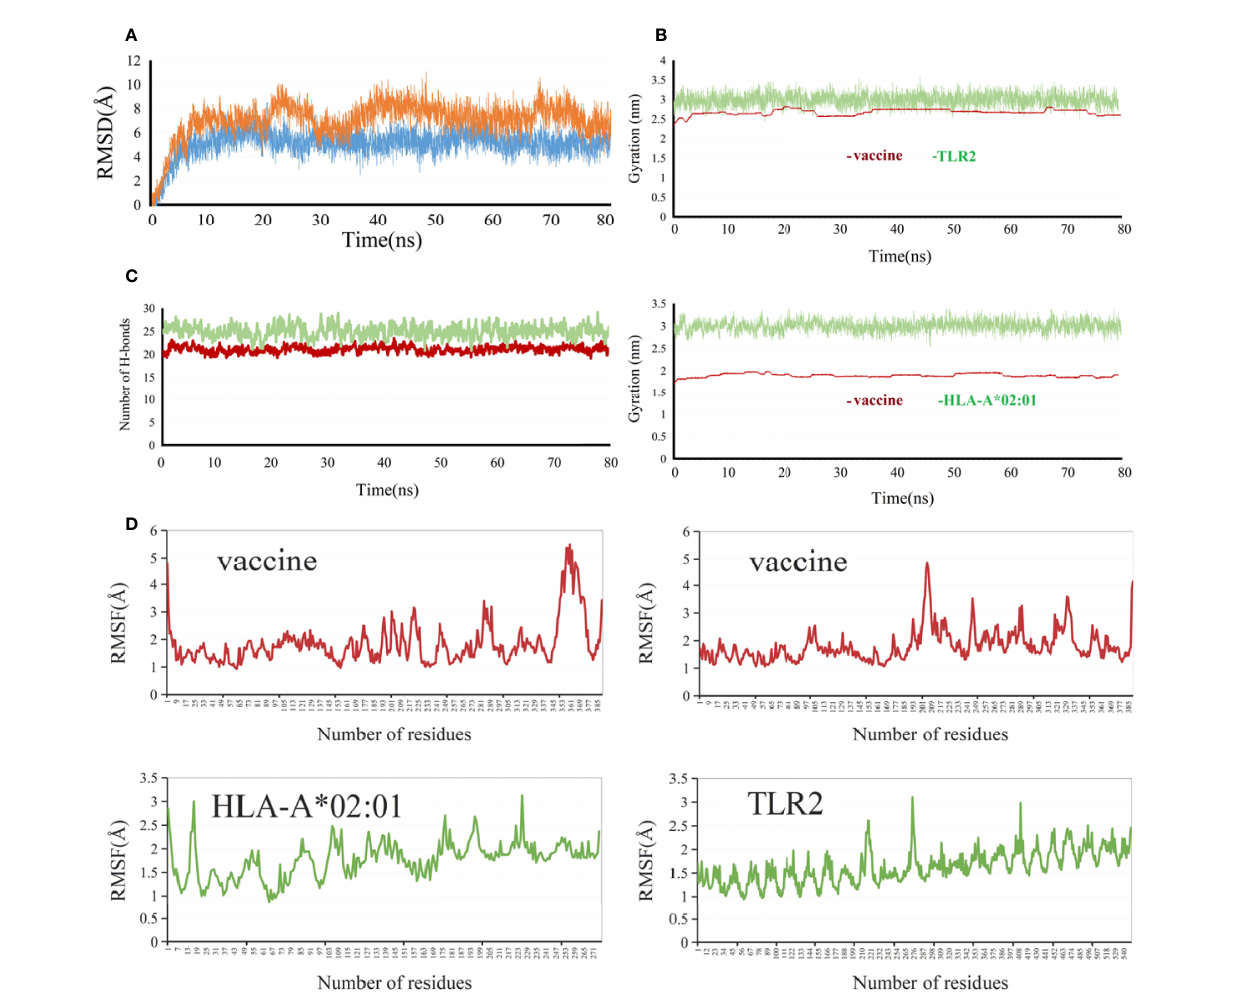
FIGURE 8 | Molecular dynamics simulation analysisofthe vaccine with TLR2 and HLA-A*0201. (A) RMSD (Root-mean-square deviation), vaccine-TLR2 (orange), vaccine- HLA-A*0201(blue) (B) RG (radius of gyration), (C) Hydrogen bonds, vaccine-TLR2 (green), vaccine-HLA-A*0201 (brown) (D) RMSF (root medium square fl